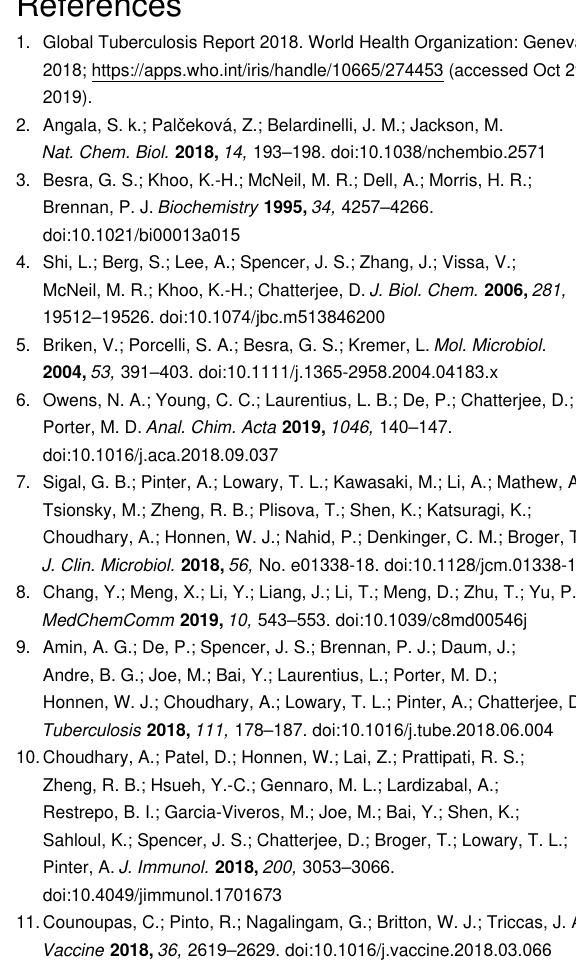
The global deprotection of oligosaccharides 4 – 9 was achieved by removal of the benzoate ester protecting groups under Zemplén methanolysis, followed by Pd/C-catalyzed hydro- genolysis of the carboxybenzyl group and the benzyl ethers. Mannosides 4 – 6 were deprotected and purified using reversed- phase HPLC to obtain fully deprotected mannosides 10 – 12 (Figure 2). For the arabinomannosides 7 – 9 , the acid-labile arabinose chain was cleaved during hydrogenation, giving a complex mixture of deletion sequences lacking one to six arabi- nose moieties. To overcome this challenge, hydrogenolysis with Pd(OH) 2 was performed to access the fully deprotected arabino- mannosides 13 – 15 (Figure